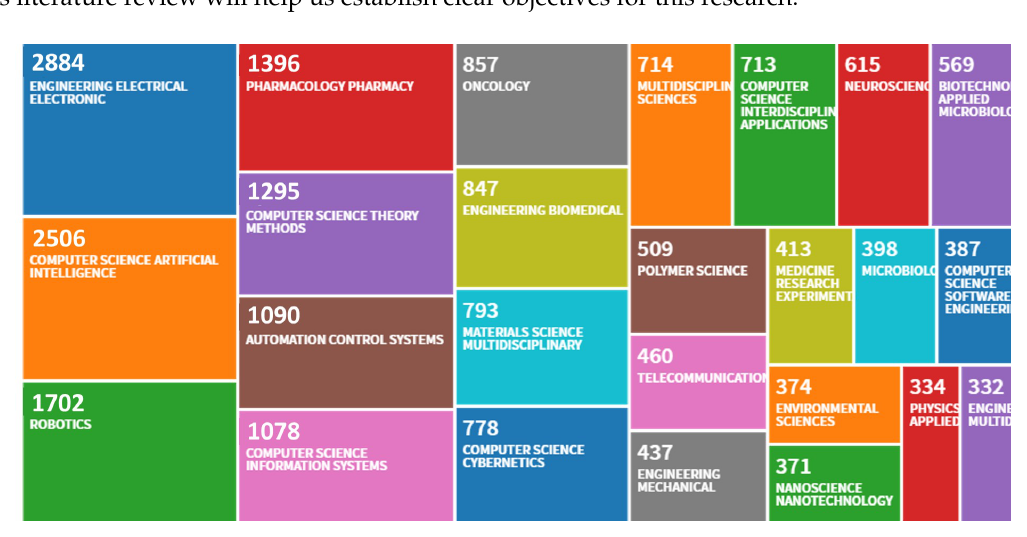
Figure 3. Visualization of research publications in the field of HMT from 2008 to 2020 as per web of sciences c (cid:13) 2020 Clarivate (reproduced from